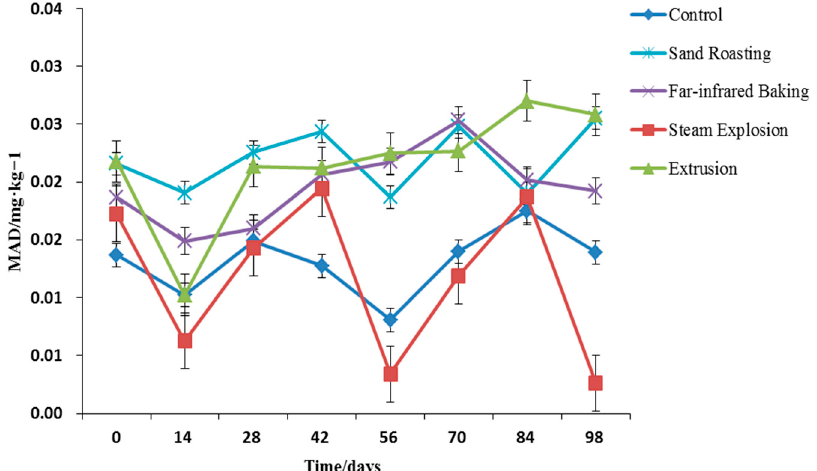
Figure 7. Malondialdehyde content of whole grain highland barley flour with different thermal treatments during storage.